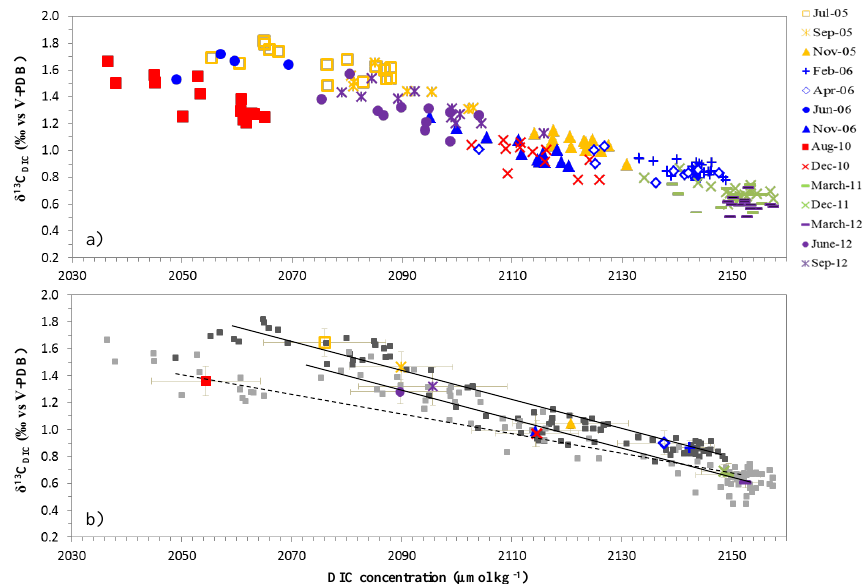
Fig. 3: (a,b) δ 13 C DIC versus dissolved inorganic carbon (DIC) concentration collected in the surface waters of the North Atlantic SubPolar Gyre (NASPG, 53°N-62°N) in 2005-06 and 2010-12. (b) Dark grey squares represent 2005-06 data set, light grey squares symbolize the 2010-12 data set and colored symbols (like Fig. 3a legend) show mean values (and standard deviation) of δ 13 C DIC and DIC concentration for each sampling period, but without June 2006 because only 4 data were sampled in the south of the transect. The linear regressions indicated with dark lines were estimated for the periods from July 2005 to June 2006 and from March 2011 to September 2012 (from the bottom up: y -0.0108x+23.81, r²=0.95 and y= -0.0108x+24.10 , r²=0.94) and with dashed line was estimated for the period from August 2010 to March 2011 (y -0.007x+16.58, r²=0.94).